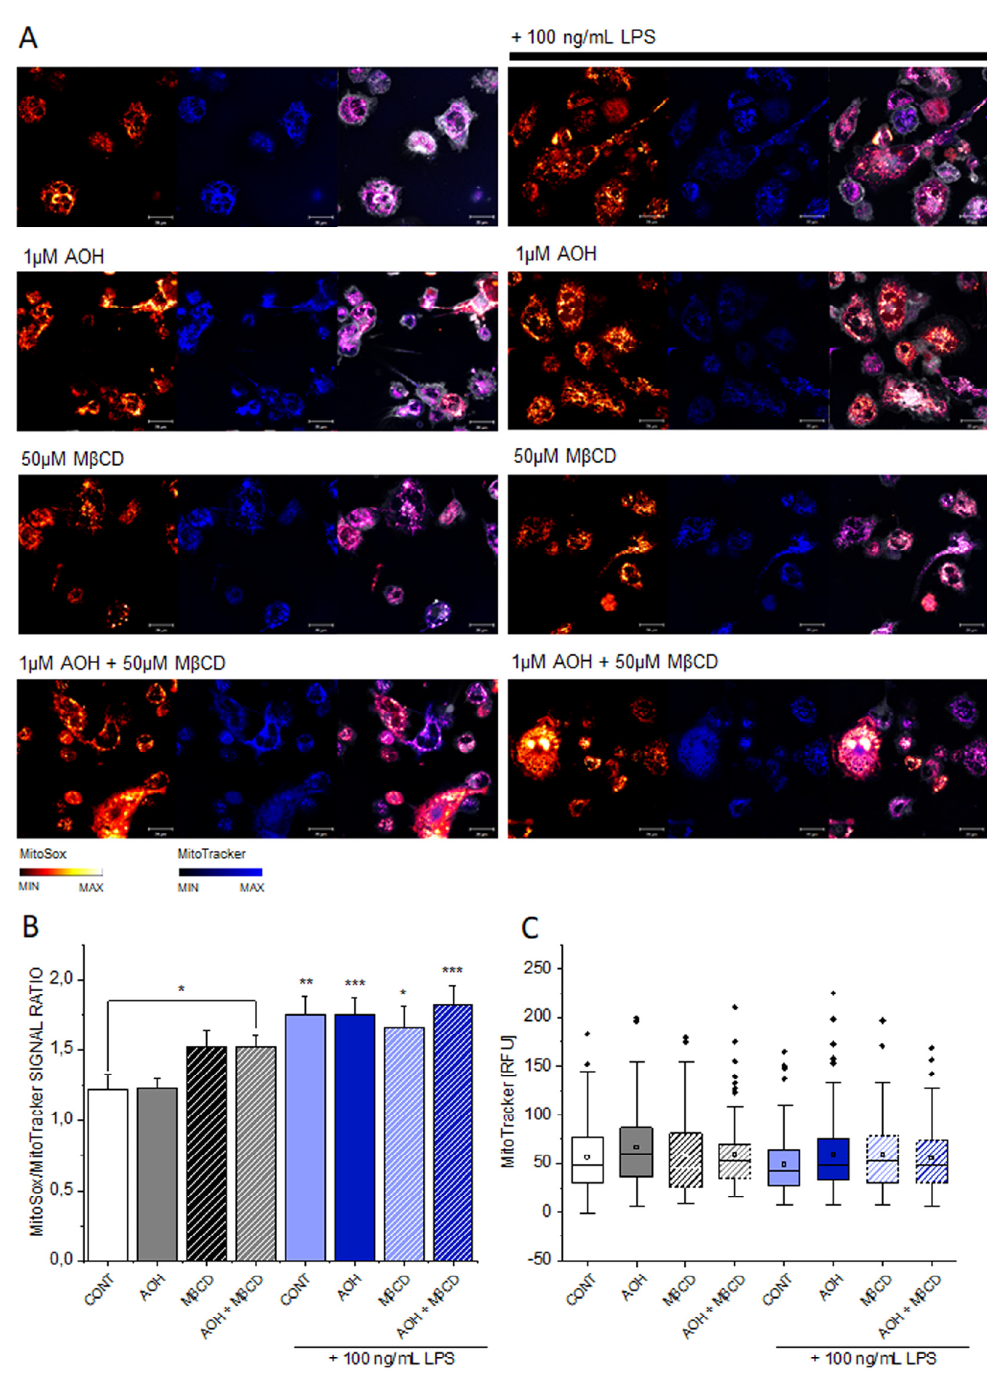
Figure3. MitochondrialsuperoxideresponseinTHP-1macrophages. SignalintensitiesofMitoSoxrange from orange to white, of MitoTracker from black to blue (see color bars) and cell membraneintensities are depicted in white ( A ). MitoSox / MitoTracker signal ratio measured after 1 h incubation ( B ). Intensity of the mitochondrial signal as reference ( C ). Incubation refer to 1 µ M AOH, 50 µ M M β CD or combination of the two in presence or absence of LPS 100 ng / mL. Scale bar, 20 µ m. Data are mean ± SEM n ≥ 80 cells from 4 independent experiments. * ( p < 0.05), ** ( p < 0.01), *** ( p < 0.001) significant di ff erence according to Student’s t -test in comparison to